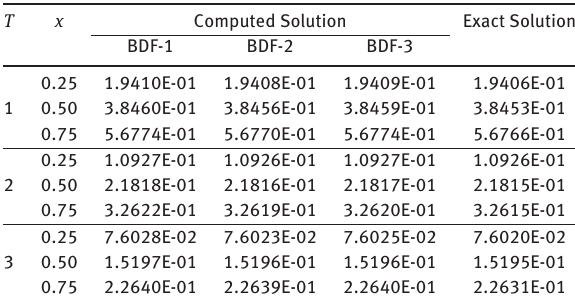
Table 8: Numerical solutions obtained by proposed schemes and the exact solutions for Example 2: ν = 0.0125 , Δx = 0.0125 and Δt = 0.0001 .